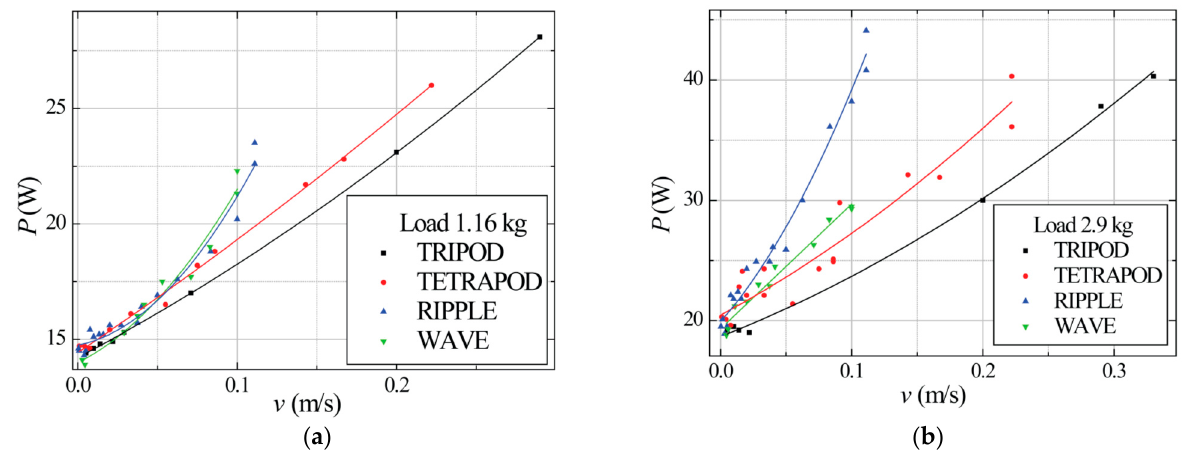
Figure 4. Average power dependence on robot speed and gaits with different robot loads: ( a ) 1.16 kg load, ( b ) 2.9 kg load. Each dot represents a separate experiment with a certain configuration. Lines show polynomial approximation. No gait switching was used.